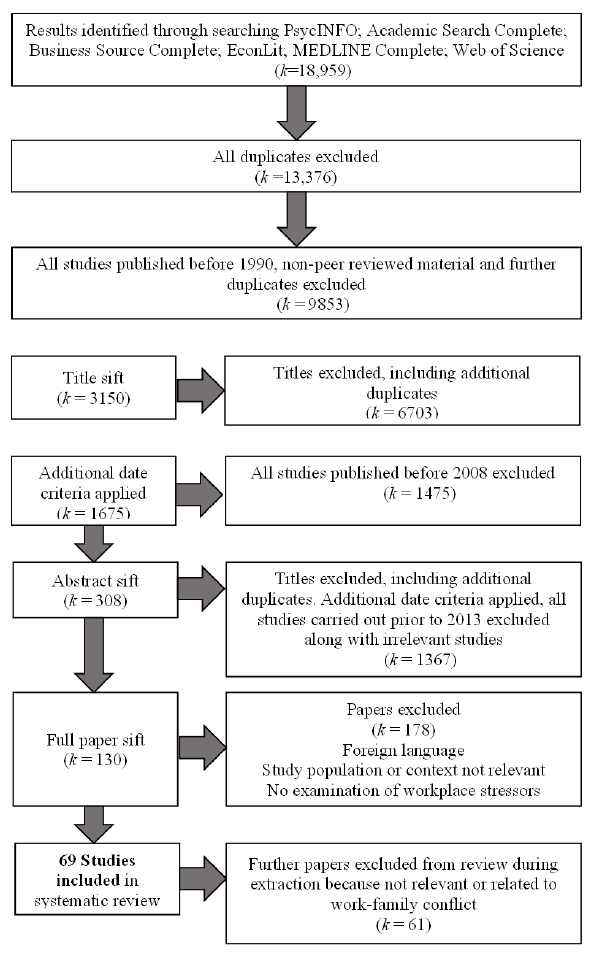
Figure 1. Flowchart of Search